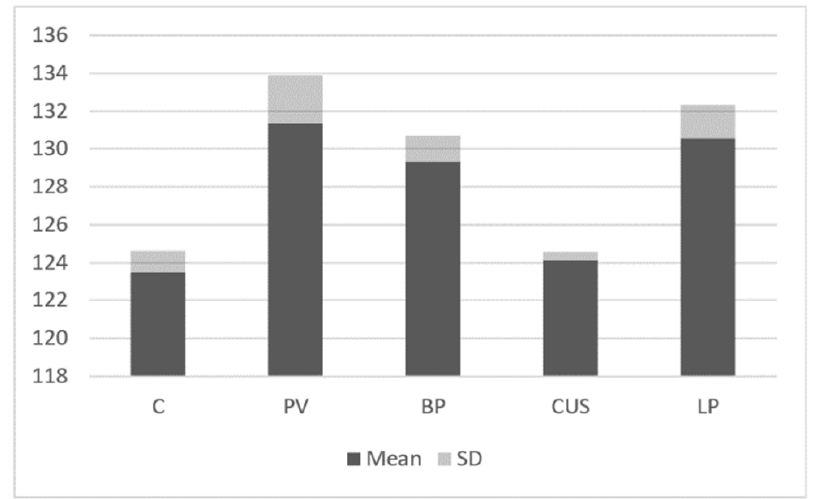
Figure 7. Immunoblotting. STAT6 expression in studies groups and control group.